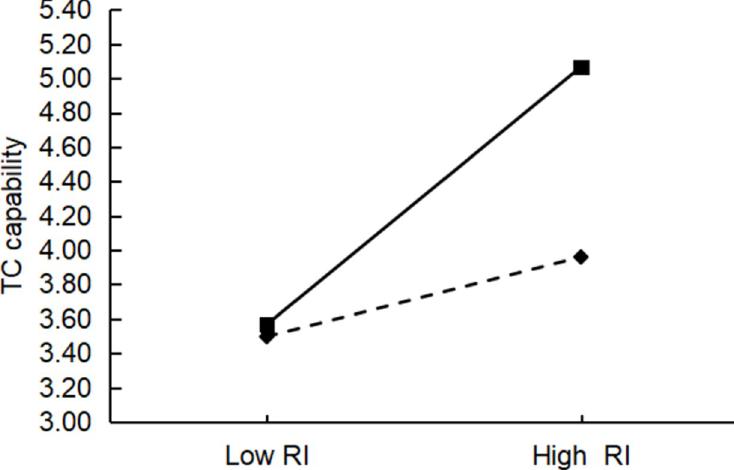
Fig 5. Test of the moderating effect of absorptive capacity differences on resource interaction and TC